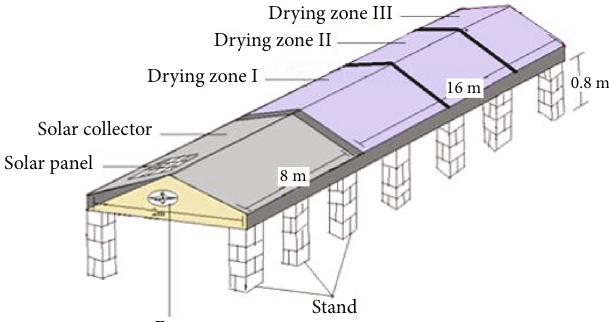
Figure 1: Schematic diagram of solar tunnel